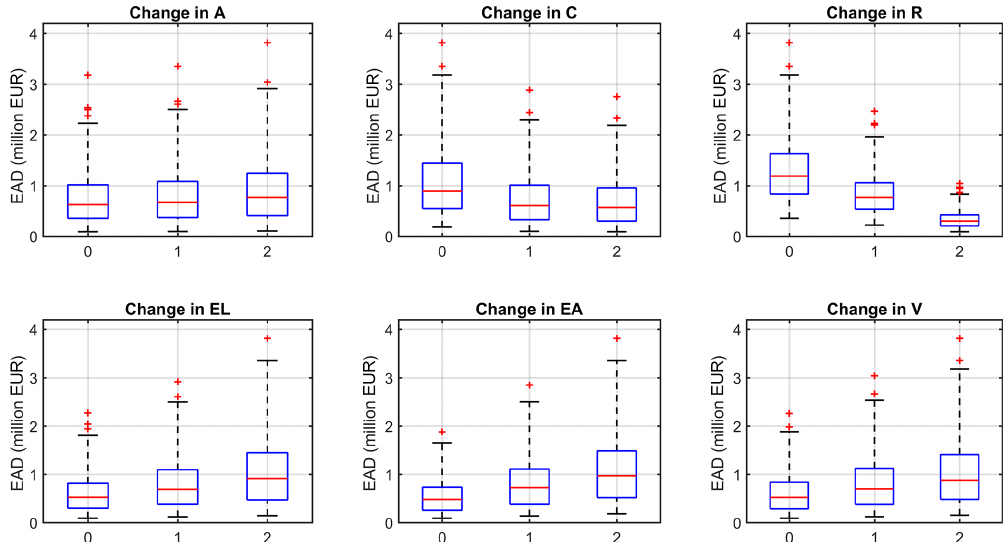
Figure 5. Box plots of EAD, aggregated at the catchment scale, for changes in six components: atmosphere (A), catchment (C), river system (R), land use (EL), asset values (EA), and vulnerability (V). The box plots show the median values (red lines), the 25th and 75th per- centiles (top and bottom of boxes), and the range (whiskers). Outliers are shown by “ +